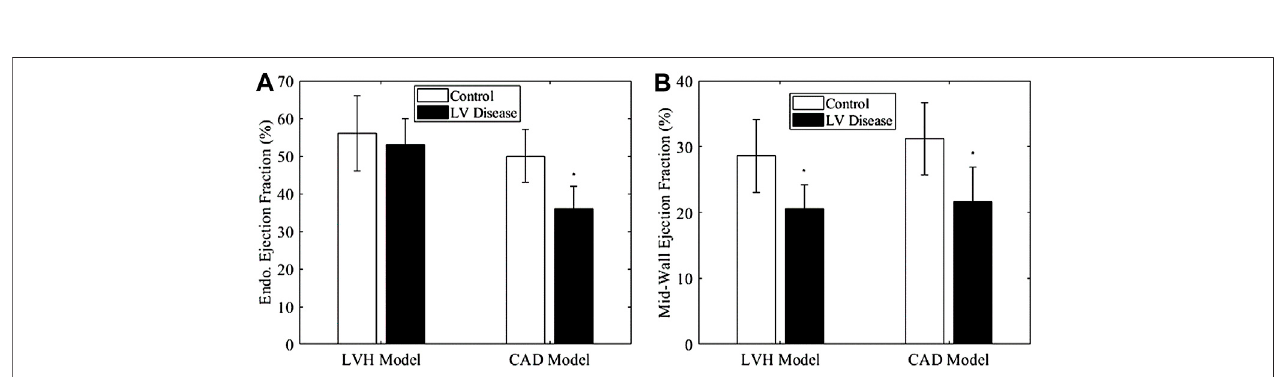
FIGURE 8 |(A) Endocardial EF and (B) mid-wall EF of LVH model and CAD model at termination, compared totheir appropriate controls. The control for LVH was sham at termination, while that for CAD group was its own data at baseline, Signi fi cance: * p < 0.05 comparing to the control group.